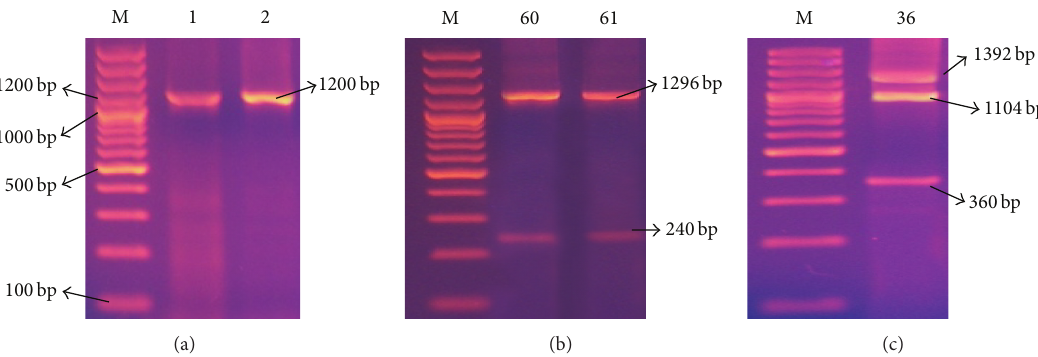
Figure 4: Representative 2% agarose gel electrophoresis of spa gene PCR products where M is DNA molecular size marker (100bp ladder). (a) Isolates 1 and 2 showing single band PCR products, (b) isolates 60 and 61 showing 2 bands PCR products, and (c) isolate 36 showing 3 bands PCR